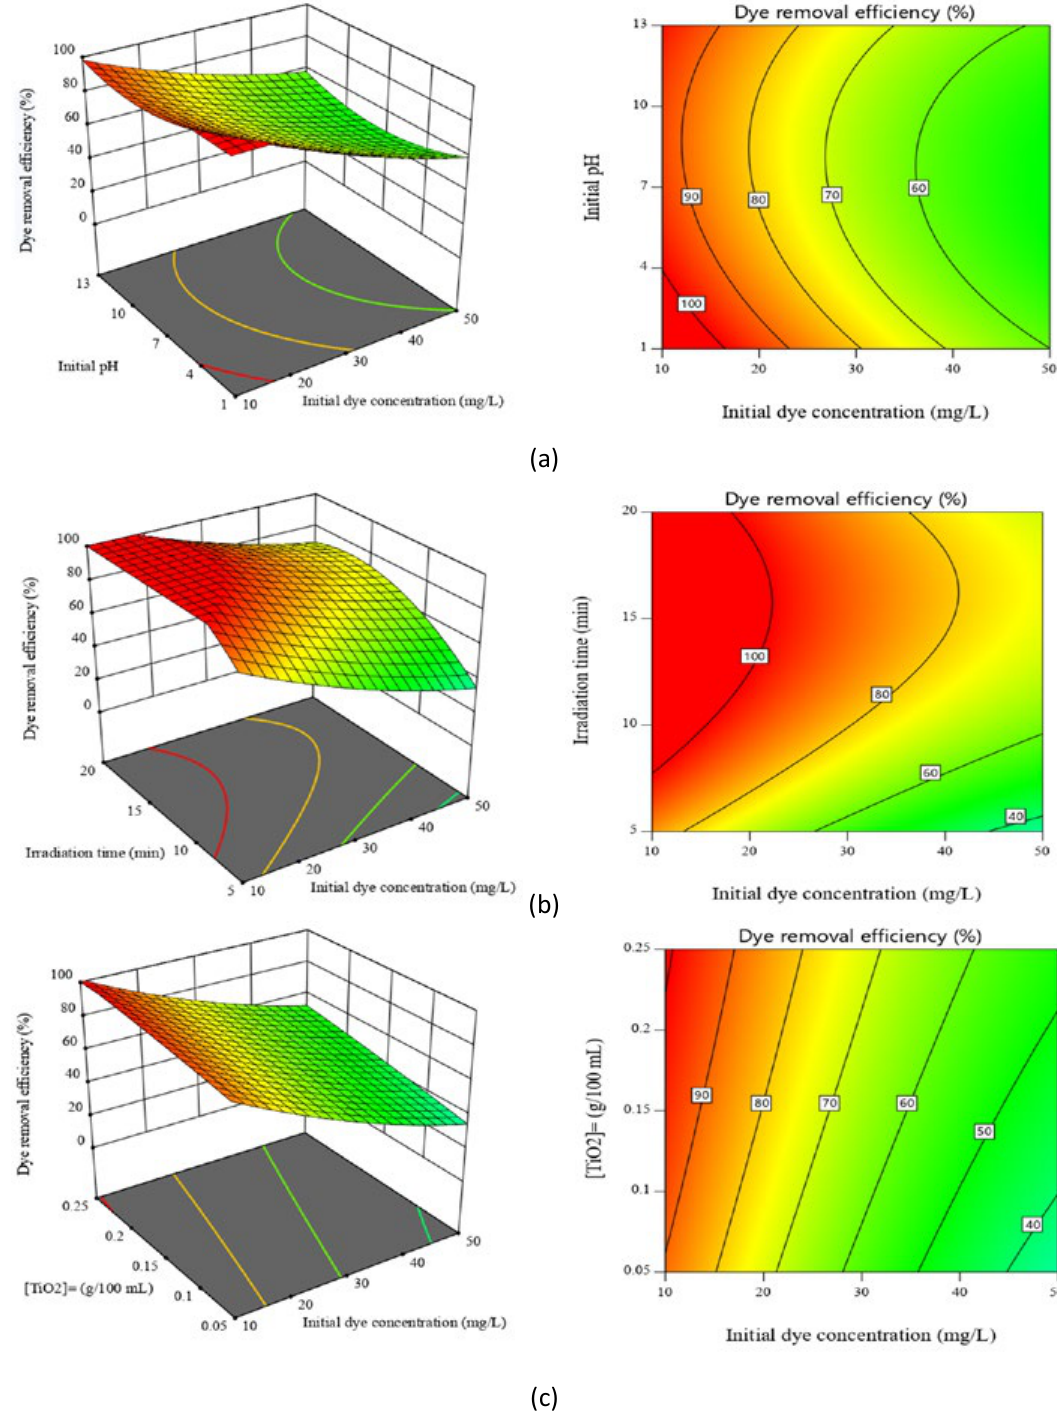
Fig. 10: The 3‐D response surface and 2‐D contour plot of dye removal efficiency (%) as a function of initial dye Fig. 10: The 3-D response surface and 2-D contour plot of dye removal efficiency (%) as a function of initial dye concentration (mg/L) in concentration (mg/L) in terms of a) initial pH b), irradiation time (min), and c) TiO 2 dosage (g/100 mL) terms of a) initial pH b), irradiation time (min), and c) TiO dosage (g/100 2